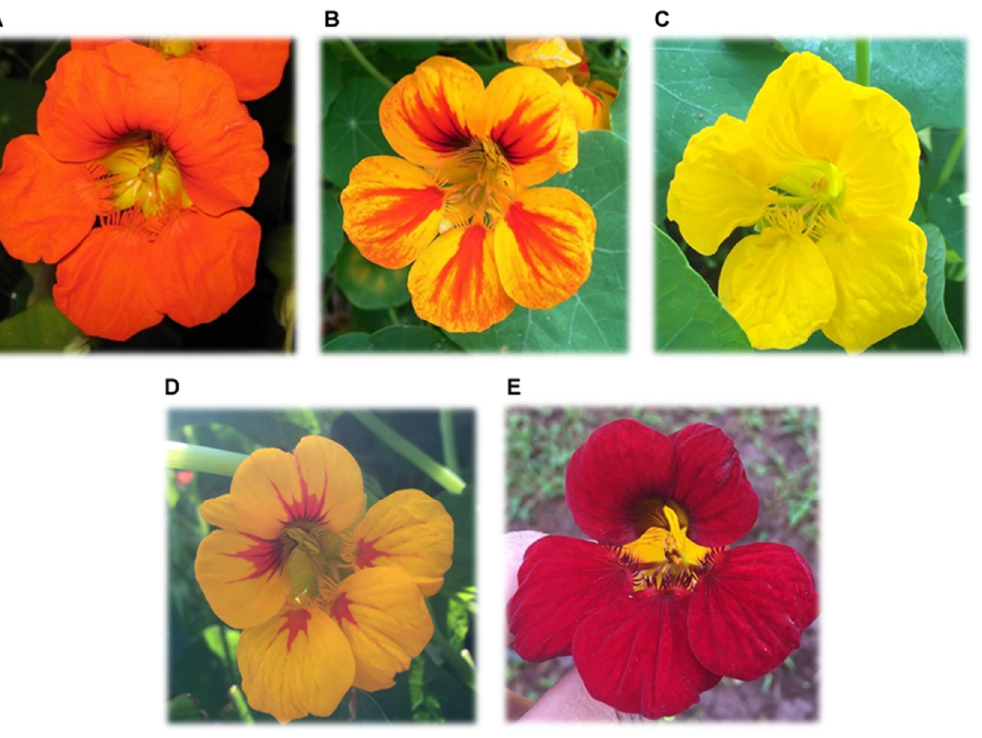
Figure 2. Corollas of Tropaeolum majus different colors found in transects and plots during the visit of bees. ( A ) Orange; ( B ) orange-red; ( C ) yellow; ( D ) yellow-red; ( E ) red.